Question: What does this figure show? Answer in one sentence.
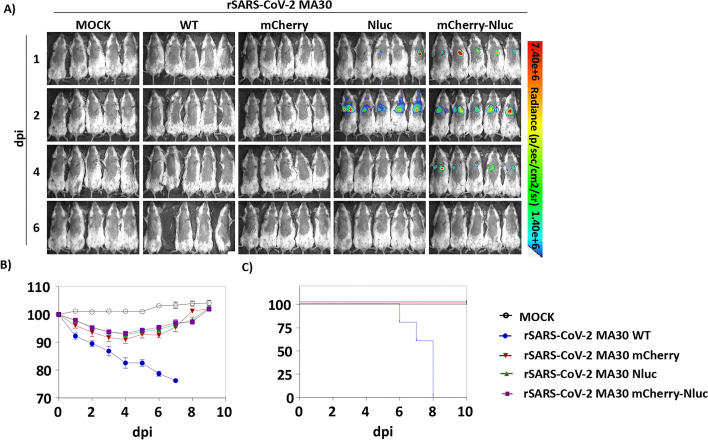
Answer: In vivo kinetics of reporter-expressing rSARS-CoV-2 MA30 in BALB/c mice: ( A ) BALB/c 22-week-old mice ( n = 5/group) were mock-infected or infected i.n. with 10 5 PFU/ mouse of rSARS-CoV-2 MA30 WT, rSARS-CoV-2 MA30 mCherry, rSARS-CoV-2 MA30 Nluc, or rSARS-CoV-2 MA30 mCherry-Nluc. Nluc expression in the whole mouse at the indicated dpi was evaluated with an Ami HT IVIS. Representative images of the same mouse at 1, 2, 4, and 6 dpi are shown. Changes in body weight ( B ) and survival ( C ) of mice infected in panel A were monitored for 10 days after viral infection.